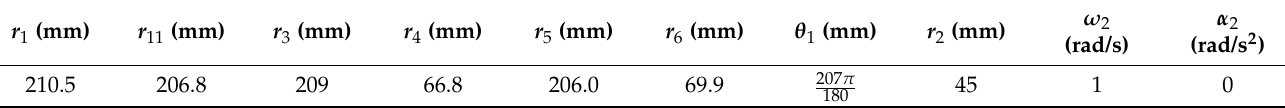
Table 1. Parameter values used in simulations.